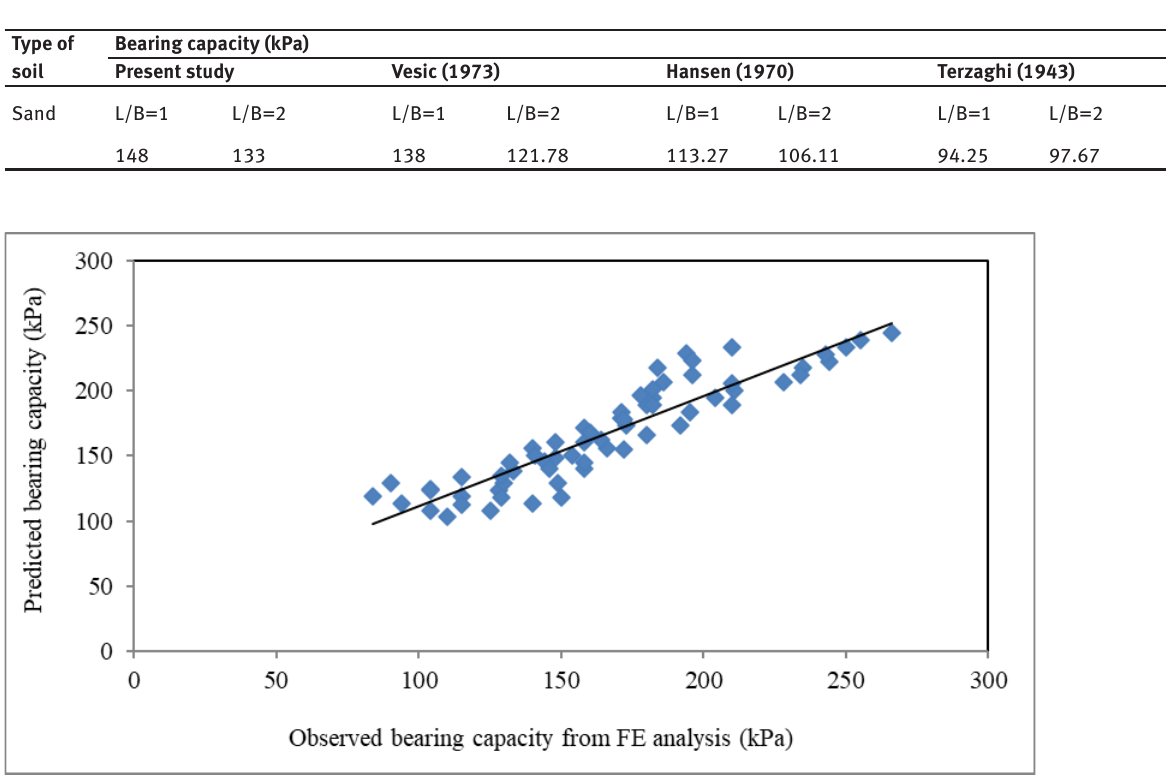
Figure 13: Variation of numerical and predicted bearing capacity for both footings (L/B= 1,